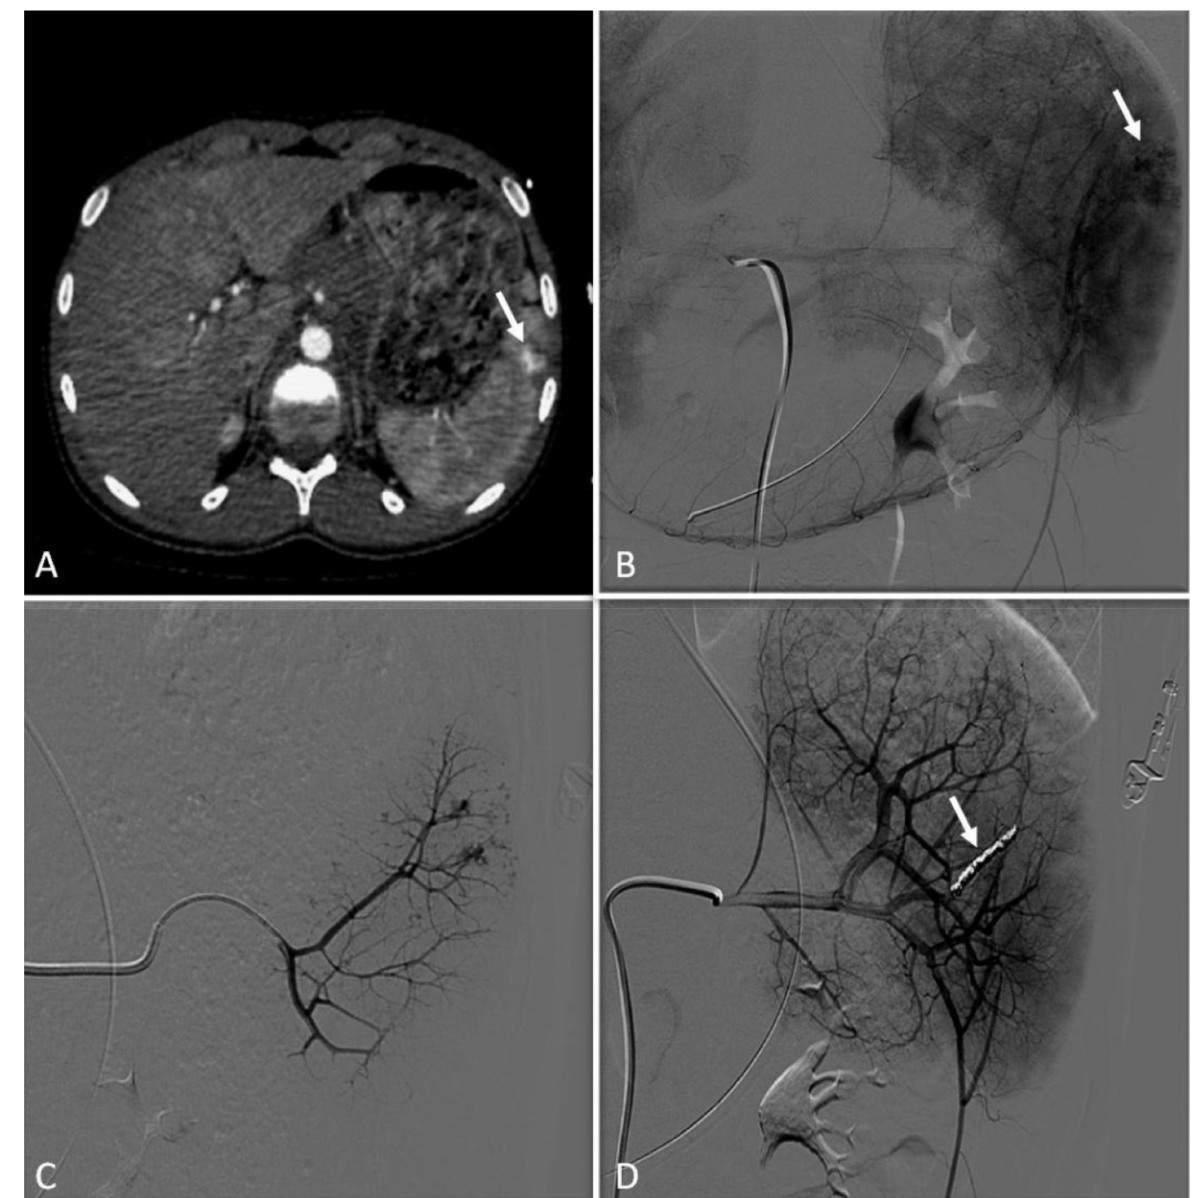
Figure 1. Transcatheter coil embolization of post-traumatic splenic bleeding in a 13-year-old female. ( A ) Axial CTA image shows a small pseudoaneurysm (arrow) along the lateral spleen margin. ( B ) DSA performed through selective 4F catheterization of the celiac trunk shows several small pseudoaneurysms within the spleen parenchyma (arrows). ( C ) DSA image of superselective coaxial 1.9F microcatheterization of the affected spleen vessel. ( D ) Control DSA image after superselective multiple 4-mm coils (arrow) embolization shows disappearance of the pseudoaneurysms, with preserved opacification of the surrounding spleen parenchyma. No further bleeding occurred,